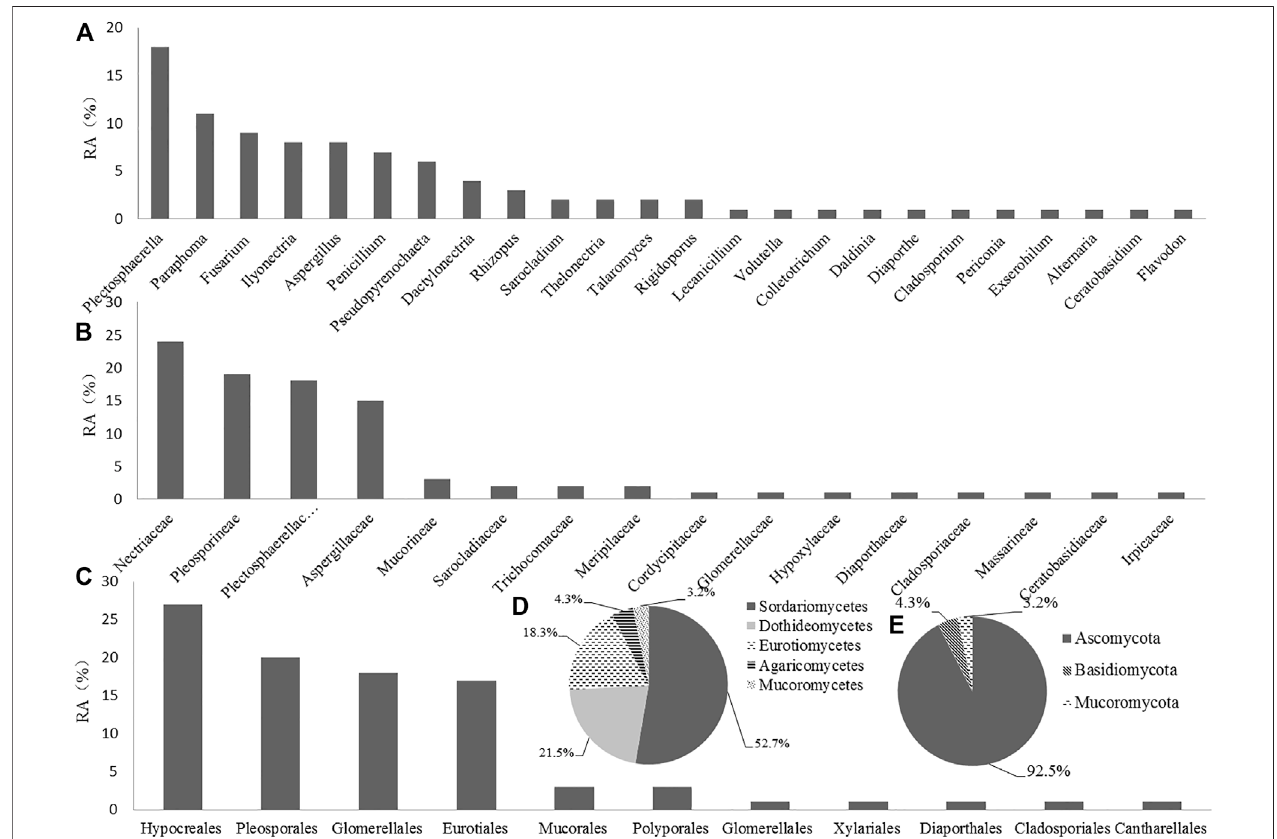
FIGURE 1 | Relative abundance (RA, %) of endophytic fungi at the level of genus (A) , family (B) , order (C) , class (D) , and phylum (E) .